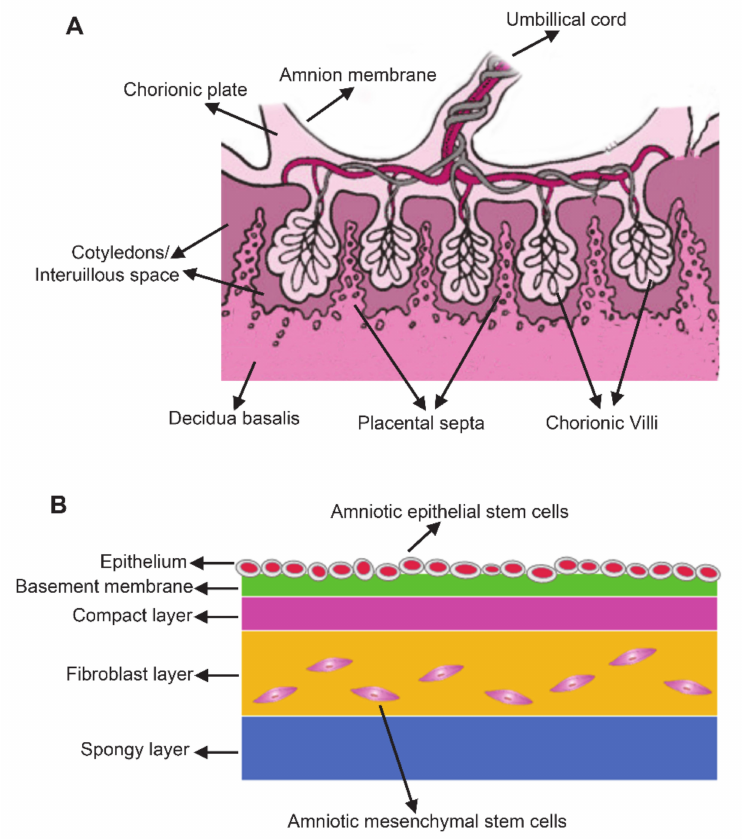
Figure 1. The anatomy of the human term placenta and amniotic membrane. ( A ) Schematic section of the human term placenta; ( B ) Schematic of amnion